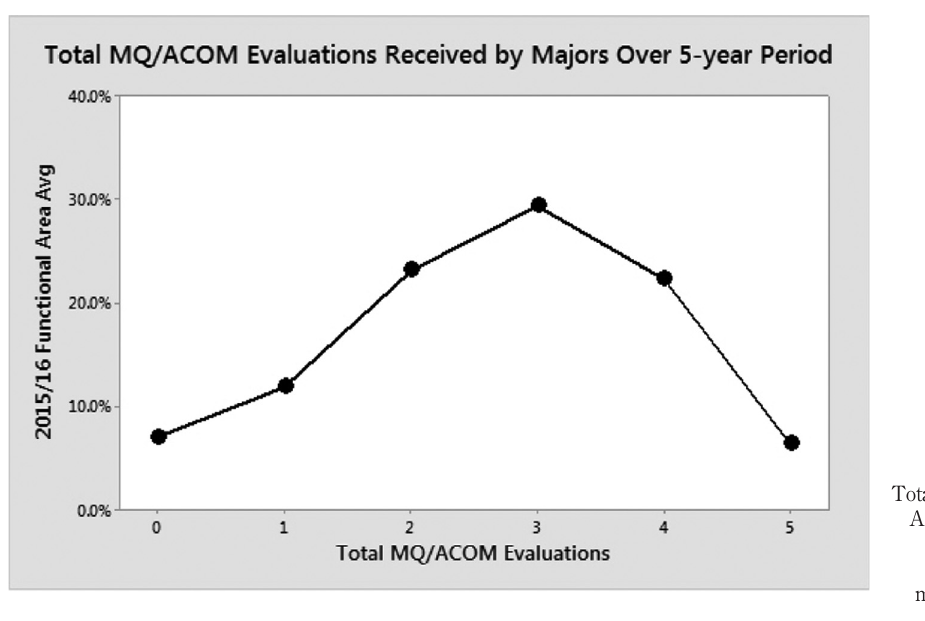
Figure 3. Percent of functional